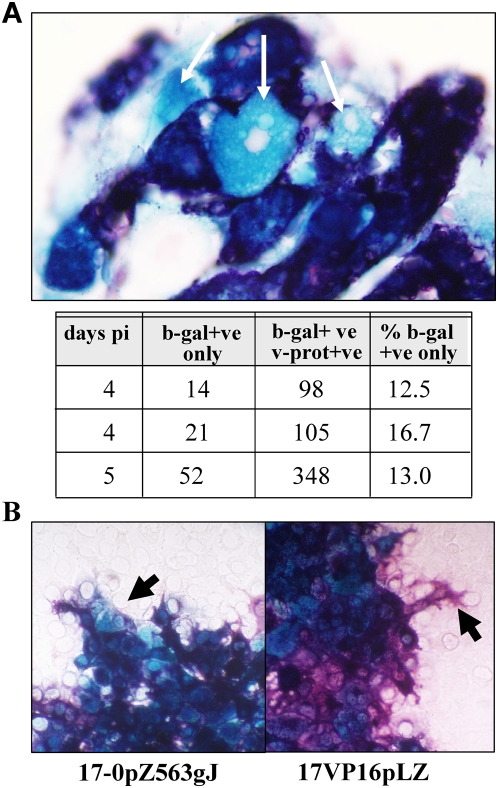
Activation of the VP16 promoter in sensory neurons during acute
infection.(A) Mice were infected with 17VP16pLZ. At the indicated days pi, TG were
removed and sequentially processed for the detection of b-gal activity
(blue) and viral proteins (purple), as detailed in Methods. A photomicrograph of a focus of infection
in a TG is shown. White arrows indicate neurons with b-gal activity with
little or no detectable viral protein. Counts of neurons positive for
only b-gal or b-gal plus viral protein are indicated below the
micrograph. (B) Photomicrographs of viral plaques on RSC monolayers
infected at low moi with 17-0pZ563gJ and 17VP16pLZ are shown. The
monolayers were stained to detect b-gal and viral proteins. At regions
at the edge of the plaques formed by 17-0pZ563gJ cells expressing b-gal
(blue) with little or no evidence of viral protein expression were
evident (arrow). Regions at the edge of plaques formed by 17VP16pLZ show
cells staining positive for viral proteins (purple) with little or no
staining for b-gal evident (arrow).